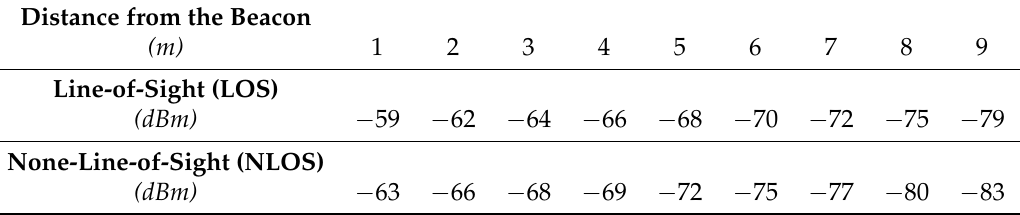
Table 2. Analysis of BLE beacon’s RSS variations under LOS and NLOS conditions.